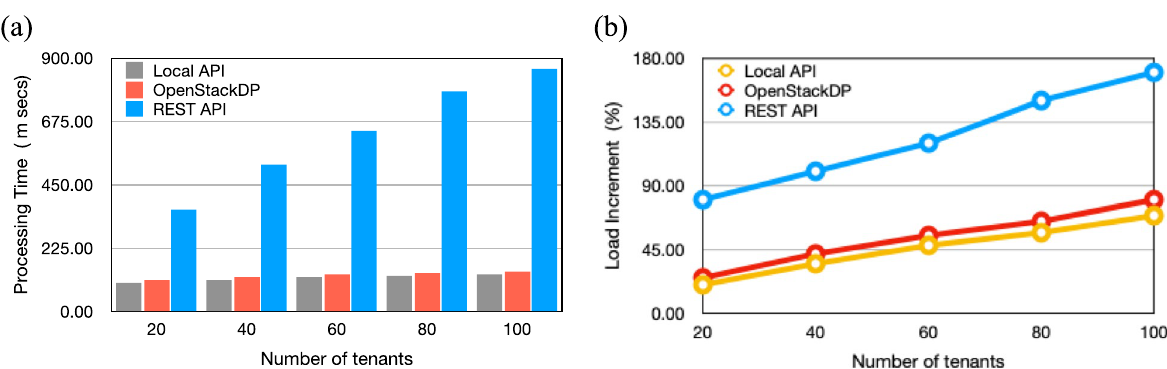
Fig. 25 OpenStackDP API. a Latency, b Load